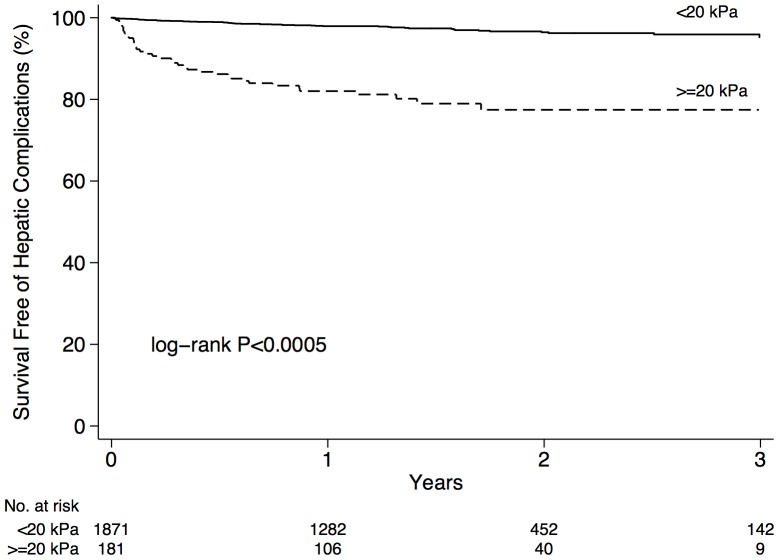
Unadjusted survival free of hepatic complications according to the 20-threshold for liver stiffness.